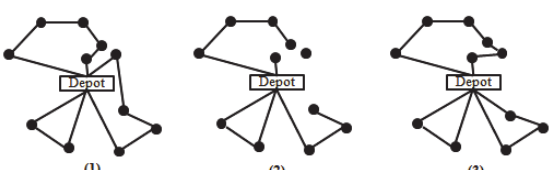
Fig. 2. 3-Opt local search. (1) The unimproved solution, (2) omitting three arcs, and (3) the improved